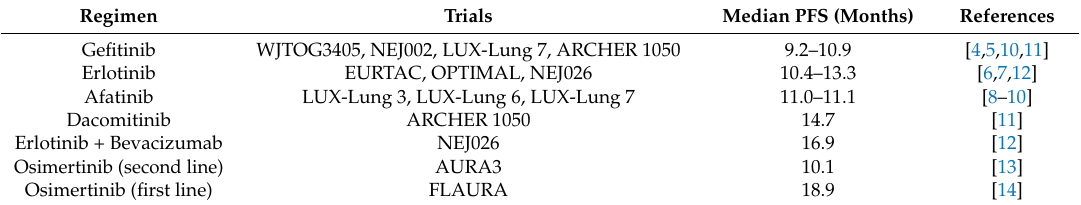
Table 1. Median progression-free survival (PFS) in clinical trials for patients with EGFR mutation–positive advanced non–small cell lung cancer (NSCLC) treated with EGFR-TKIs. Regimen